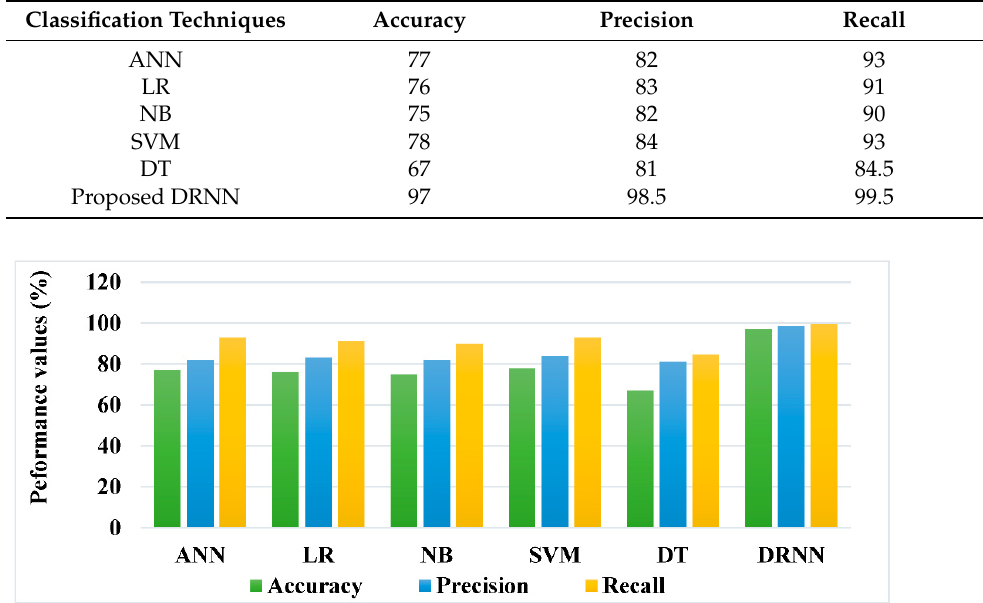
Table 1. Accuracy, precision, and recall measures of existing and proposed techniques. Classification Techniques